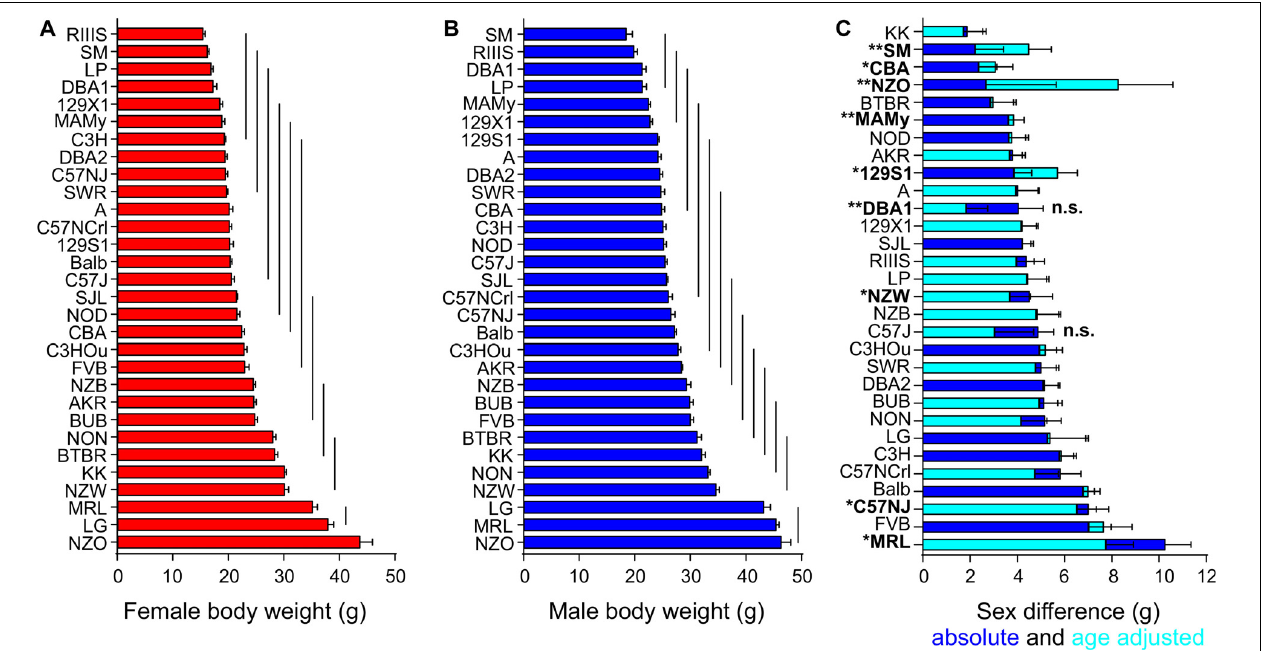
FIGURE 1 | Body weight is a sexual dimorphic trait and varies with the strain background. Body weight distribution among females in red (A) and males in blue (B) of the 30 inbred strains and quantified sex difference (C) . In all strains, males (shown as blue bars) had higher body weight than females. Horizontal bars on columns in (A,B) represent standard errors of the mean and in panel (C) the standard error of the difference. The vertical lines in (A,B) connect groups with homogenous means according to Tukey’s post hoc test. The age-adjusted sex difference for all strains is illustrated in cyan. “n.s.” not significant sex difference in body weight, all other strains are significant at a p -level < 0.05. Asterisks and bold font indicate a significant age difference, * p < 0.05, ** p <